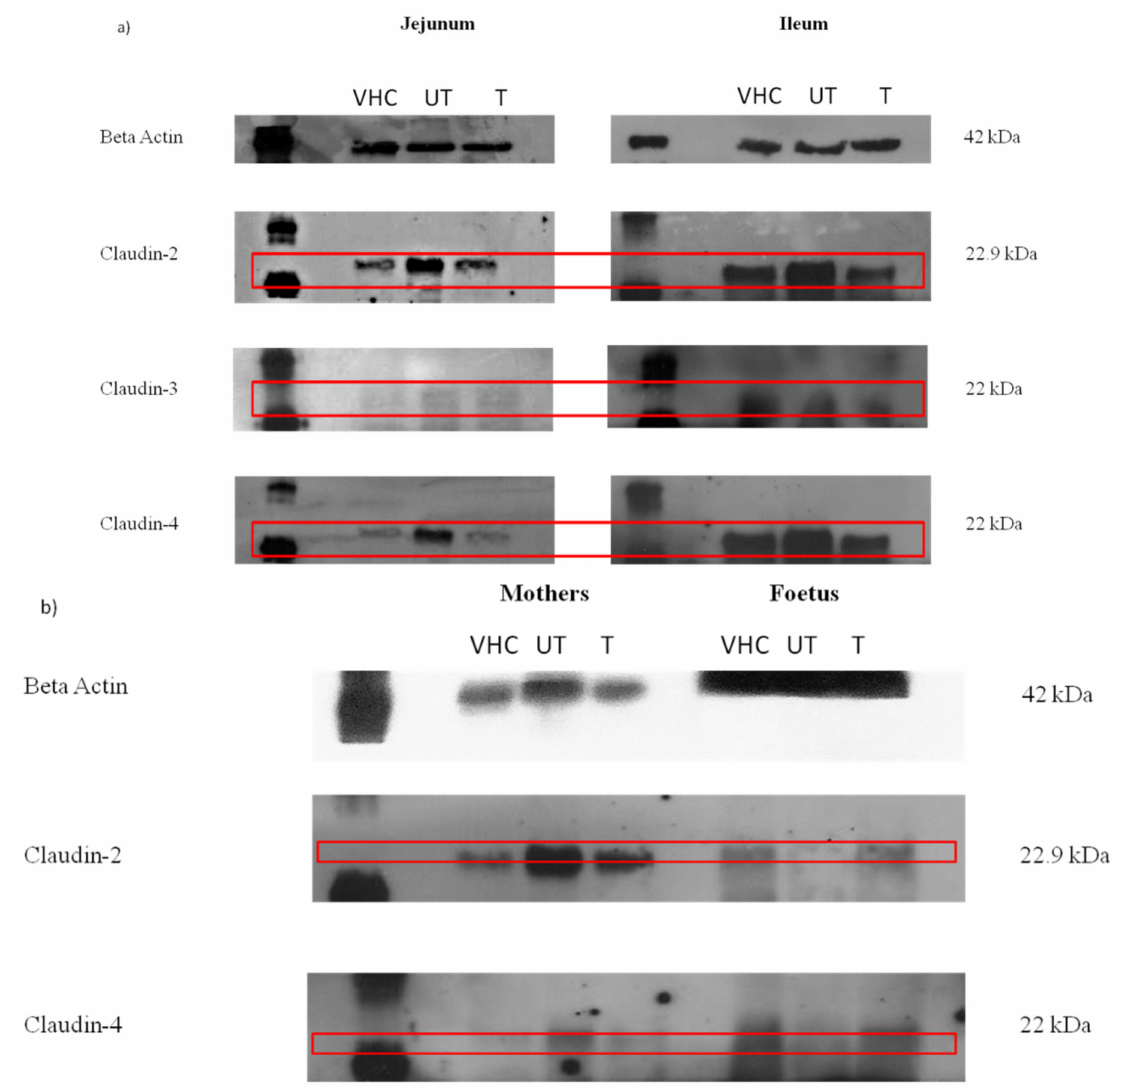
Figure 6. Representative diagram of Western blotting of the jejunum and ileum collected from ( a ) pregnant rats and ( b ) fetuses from the VHC TN80, BPA-untreated (UT) water, and BPA-treated (T) water groups ( n = 3–5 rats per